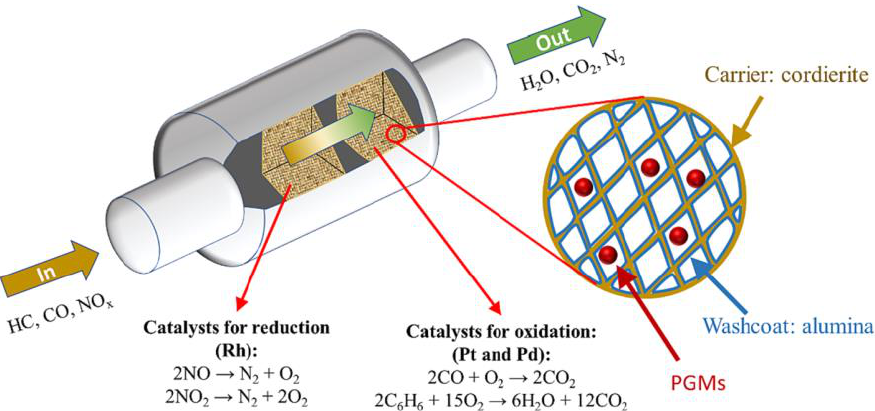
Figure 2. Scheme of automotive catalytic converter. Reprinted from [20], with permission from Elsevier, copyright 2023.